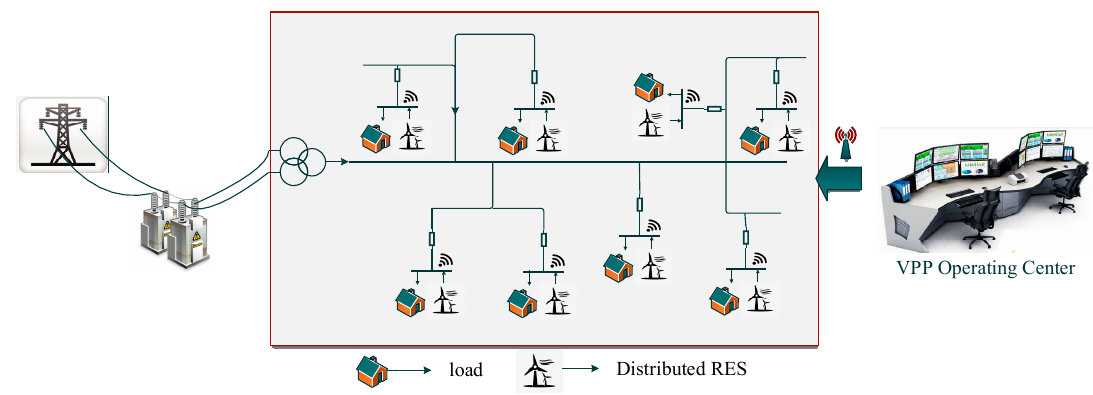
Figure 1. VPP operation framework based on ESM.